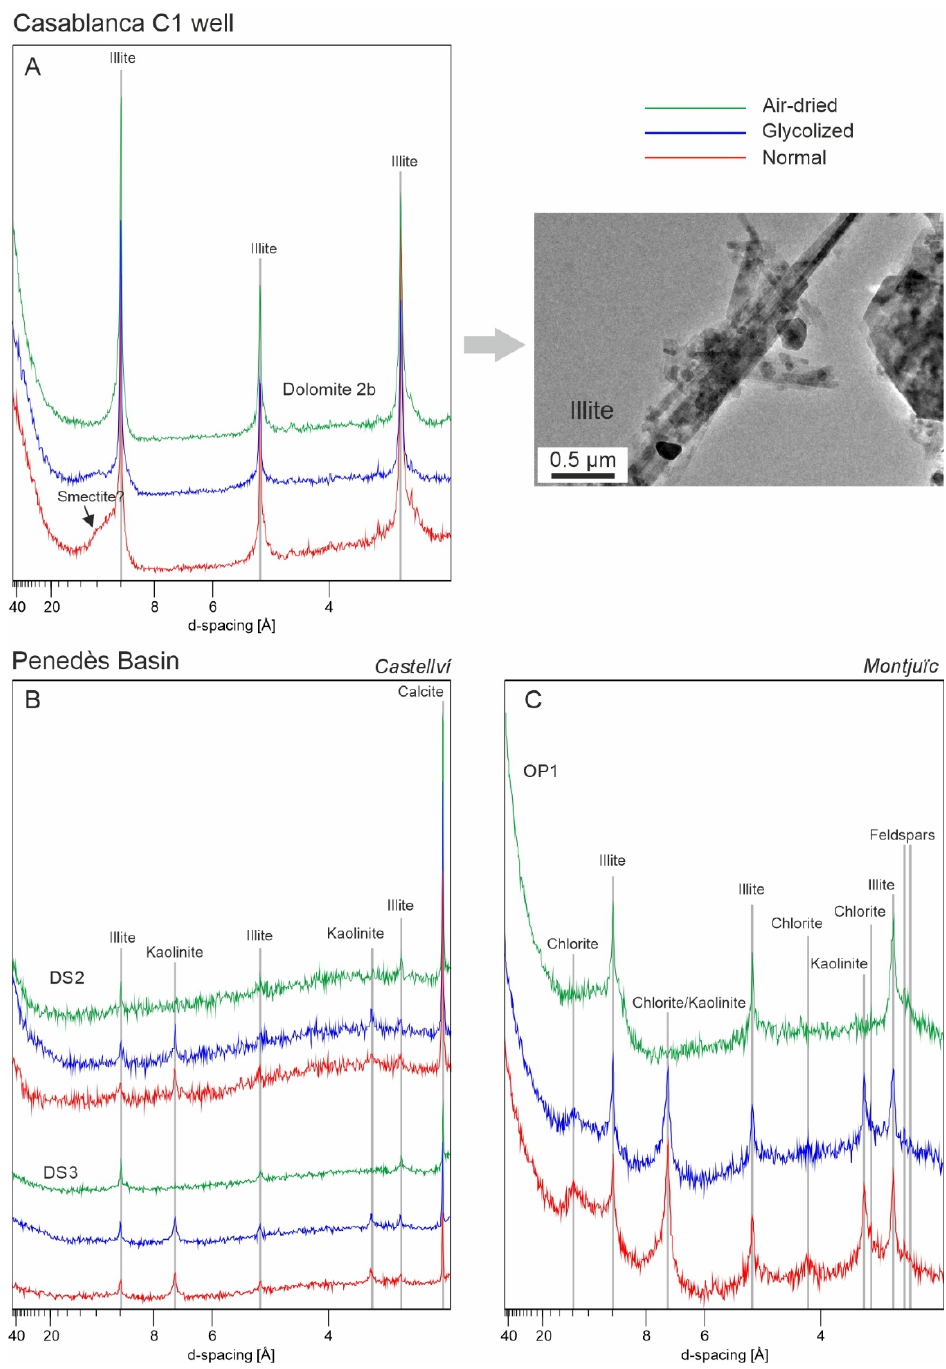
Figure 4. Air-dried, ETG and heated (550 ◦ C) XRD diagrams of the non-carbonate fraction of Dolomite 2b fills in the Casablanca-1A well, DS2 and DS3 dolomite fills in Castellv í outcrop and orange pisoids in the Montjuïc outcrop. For Dolomite 2a, XRD spectra are redrawn from [15].